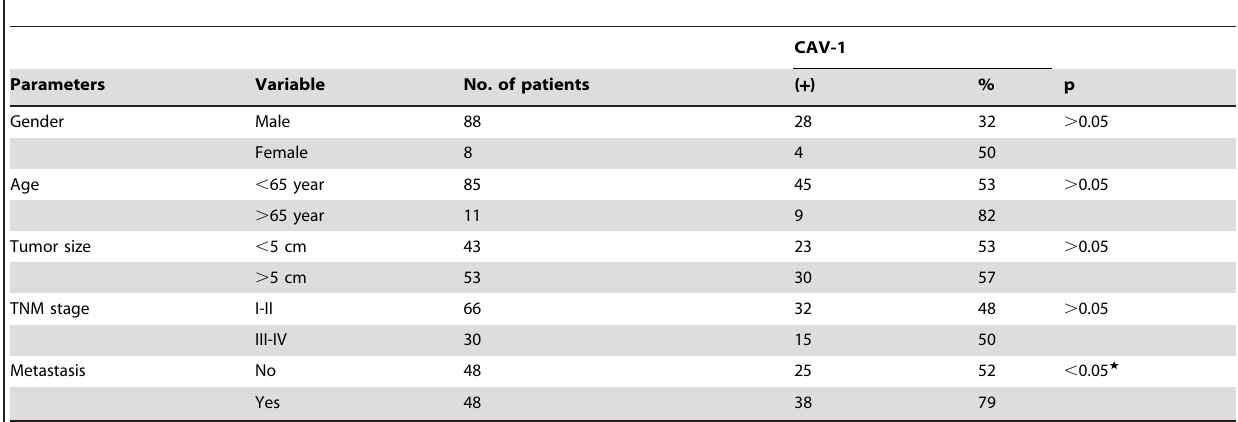
Table 1. Relationship between CAV1 expression and clinicopathological variables in the 96 HCC patients